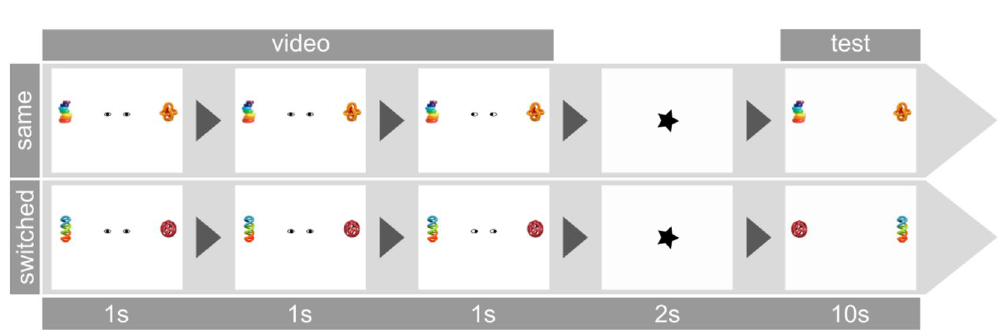
Figure 1. Overlay of the schematic eyes used in the current study in the natural-contrast condition and the stimulus used in the eye gaze condition by Hoehl, et al . 22 . The size and the movement of the schematic stimuli in the current study match the ones of the eyes in the video of the real person.